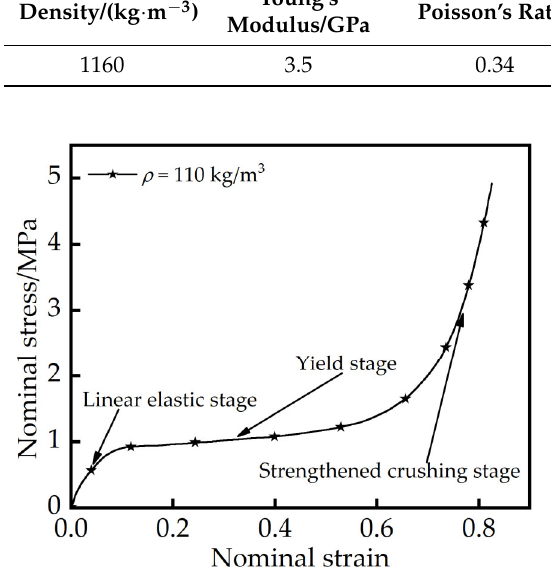
Figure 3. Compression stress–strain curve of buffer.